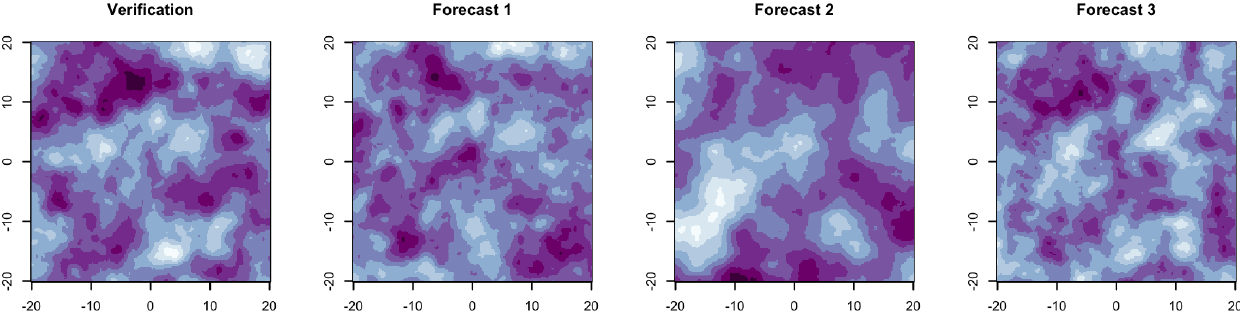
Figure 1. Simulated verification field and three associated forecast fields (arbitrary color scale) in which the spatial correlation length is either the same as for the verification, 10% miscalibrated, or 50% miscalibrated. Can you tell which is